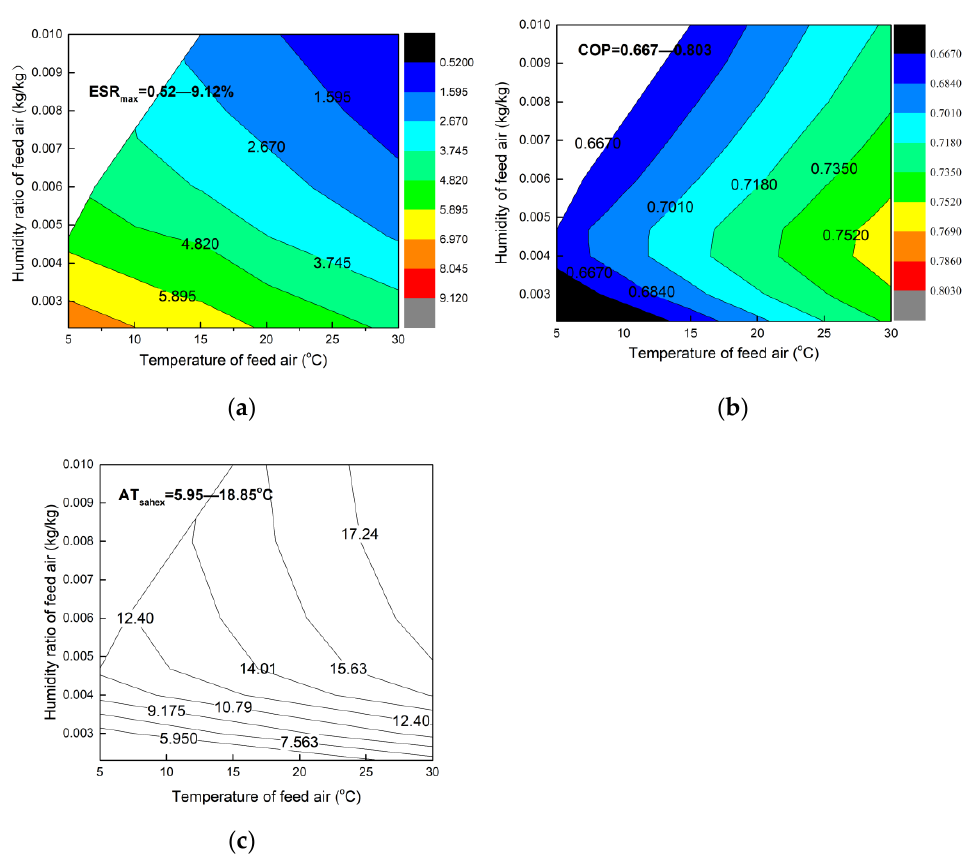
Figure 10. Influences of feed air temperature and humidity ratio on : ( a ) ESR ; ( b ) COP ; ( c ) AT sahex .